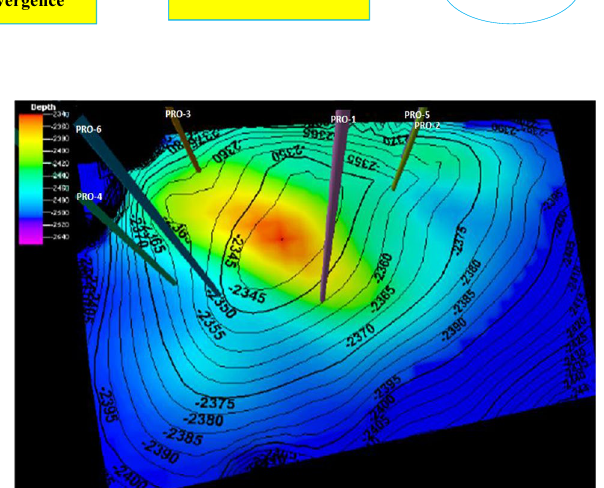
Fig. 2 Contour map showing oil saturation at various depths with location of appraisal